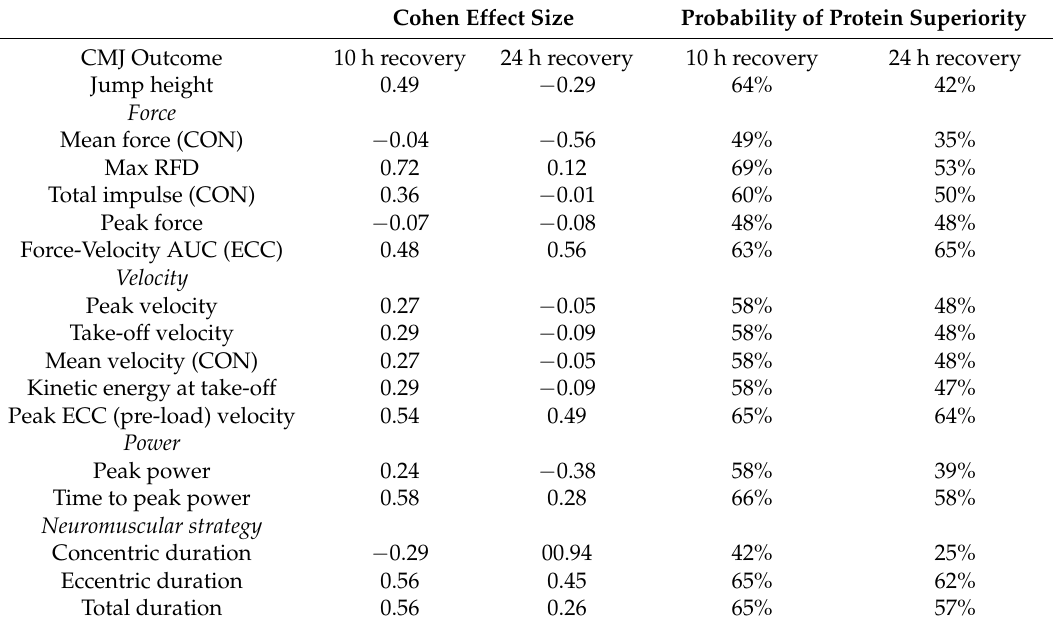
Table 2. Neuromuscular fatigue effect sizes: REx + CHO vs. REx +